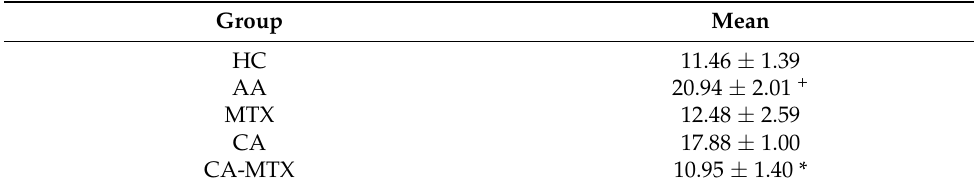
Table 1. Levels of gamma-glutamyl transferase (GGT) in joint. + HC vs. AA, * AA vs. MTX/CA/CA- MTX, p ≤ 0.05.